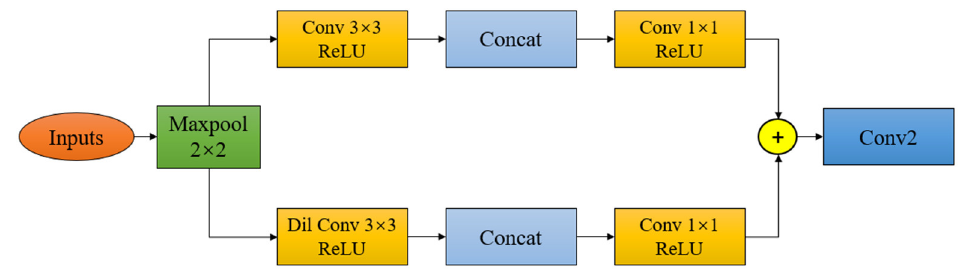
Figure 5. Improved dense block internal structure.